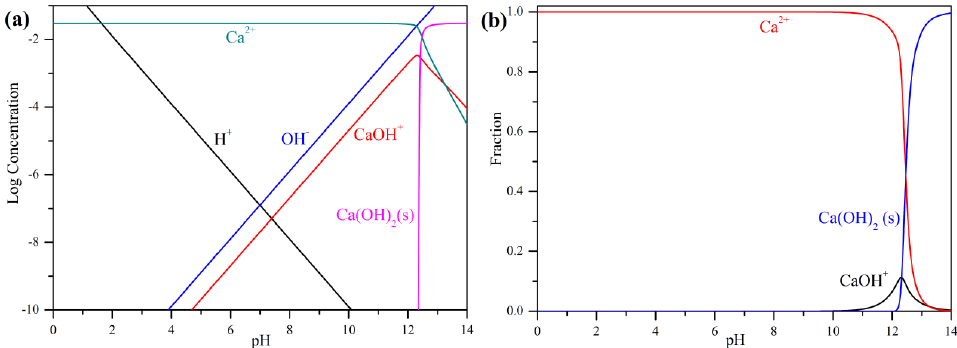
Figure 1. Calculated species distributions of 30 mM Ca(OH) 2 at different pH: ( a ) with log concentration vs. pH; ( b ) with fraction of calcium vs. pH. Table 2. Calculated concentrations of different species in saturated Ca(OH) 2 , CaCO 3 , and CaSO 4 solutions.